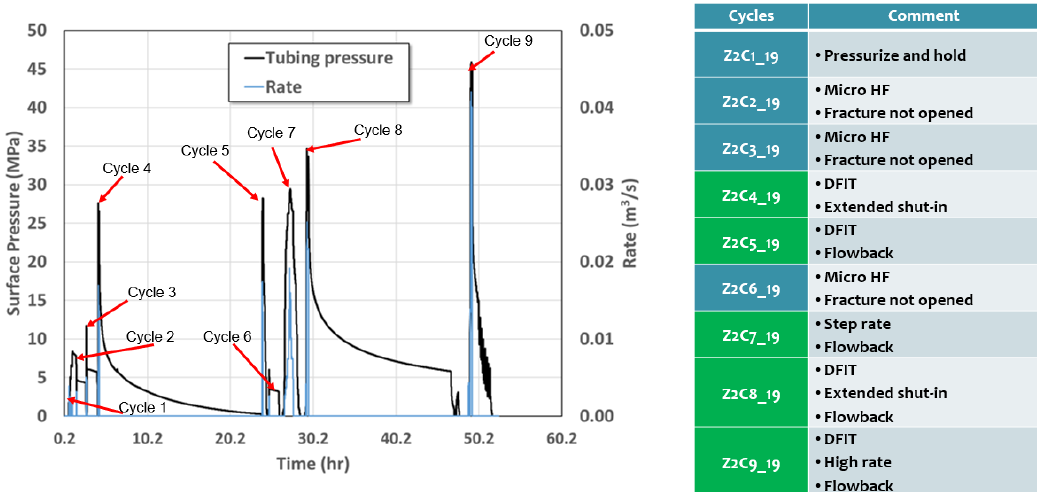
Figure 7. Pressure-rate relationships during the 2019 injection testing of Zone 2 (Z2) during Cycles 1–9 (C1–9). The cycle designation indicates the zone, the cycle number, and the year the measurements were made. See Figure 5 for abbreviations.